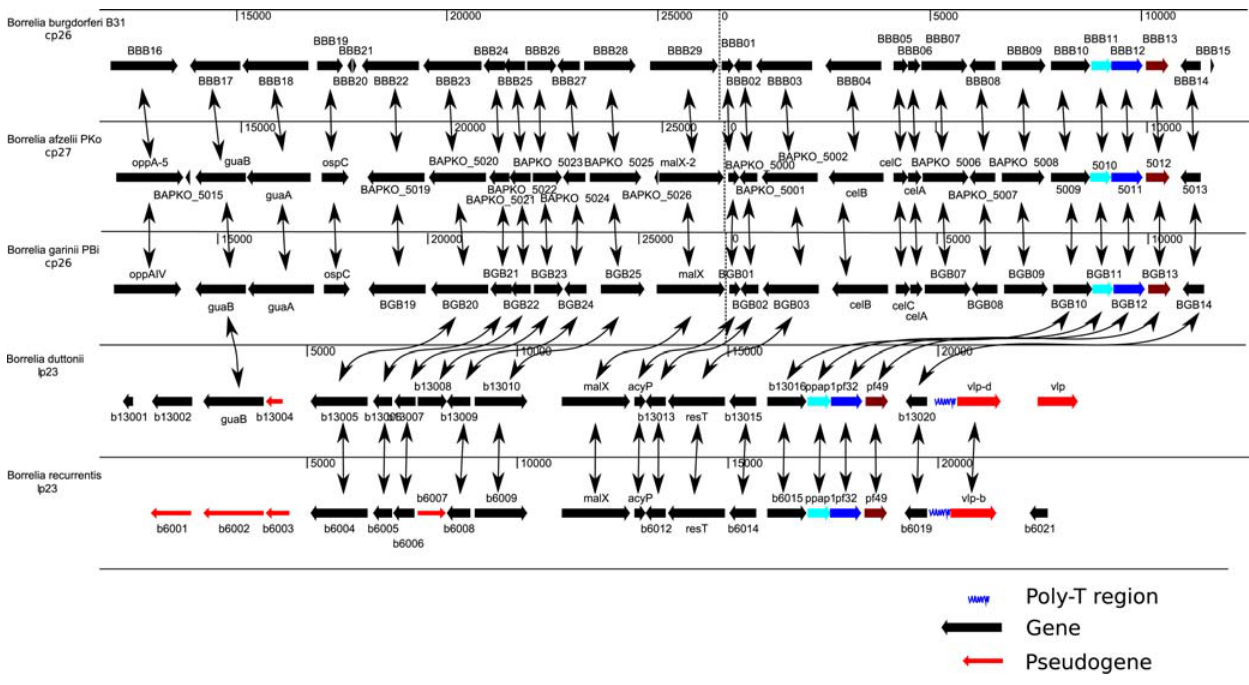
Figure 3. Comparison between recurrent fever group lp23 linear plasmid and B.burgdorferi / B.garinii -cp26, and B.afzelii -cp27 encoding telomere resolvase indicates a common structure. The large poly-T track in the promoter region of an intact vlp gene was specific to recurrent fever borreliae.